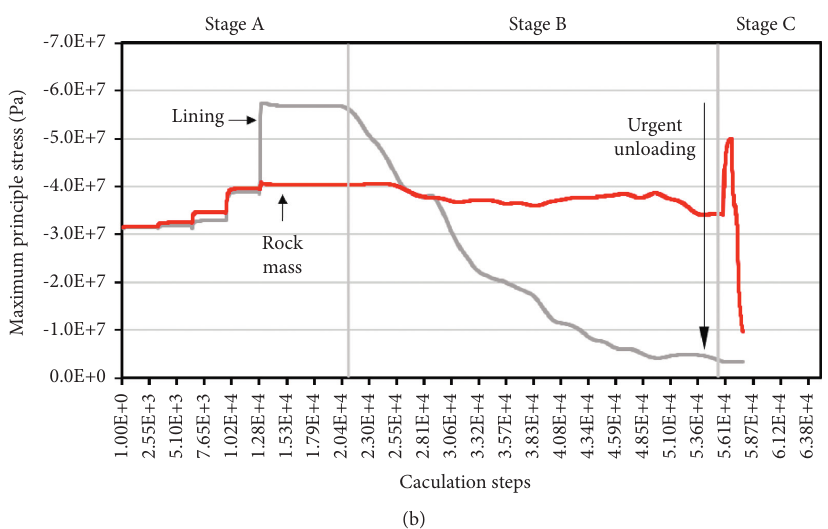
Figure 13: Stress monitoring of excavation and blasting during rockburst: (a) weak support stiffness; (b) strong support stiffness. Stage A is the excavation stage, stage B is the blasting vibration stage, and stage C is the rockburst stage.